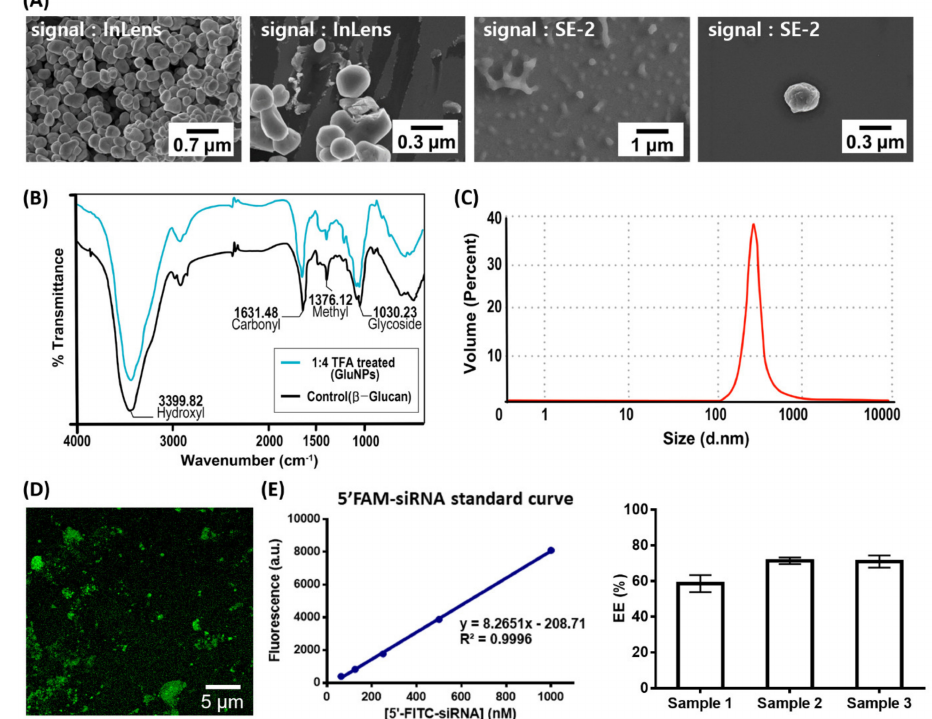
Figure 2. Characterization of the β -glucan nanoparticles (GluNPs) and siRNA entrapment e ffi ciency (EE) evaluation. ( A ) Field emission-scanning electron microscopy analyses of the GluNPs using in-lens images taken at 1.6 kB; SE-2 images taken at 20 kV using a secondary electron microscope. ( B ) Fourier-transform infrared spectra of GluNPs (black) and TFA-treated GluNPs (red), and ( C ) size distribution of the GluNPs by volume measured using dynamic light scattering analysis. ( D ) Confocal microscopy analysis and ( E ) EE of three di ff erent samples (sample 1 (1:9 TFA treated), sample 2 (1:4 TFA treated), and sample 3 (1:1 TFA treated)) of 5 (cid:48) -FAM-siRNA / GluNPs calculated based on fluorescence measurements. The data are presented as mean ± SEM of three independent experiments. FAM, 5 (cid:48) -carboxyfluorescein; excitation max. = 495 nm, emission max. = 520